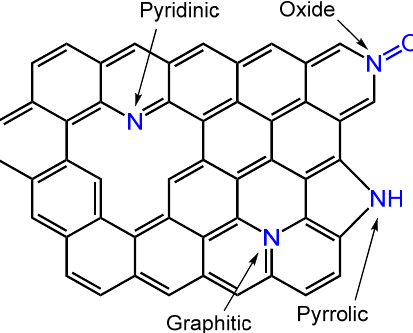
Figure 1. Representation of various nitrogen forms in N-CNTs.